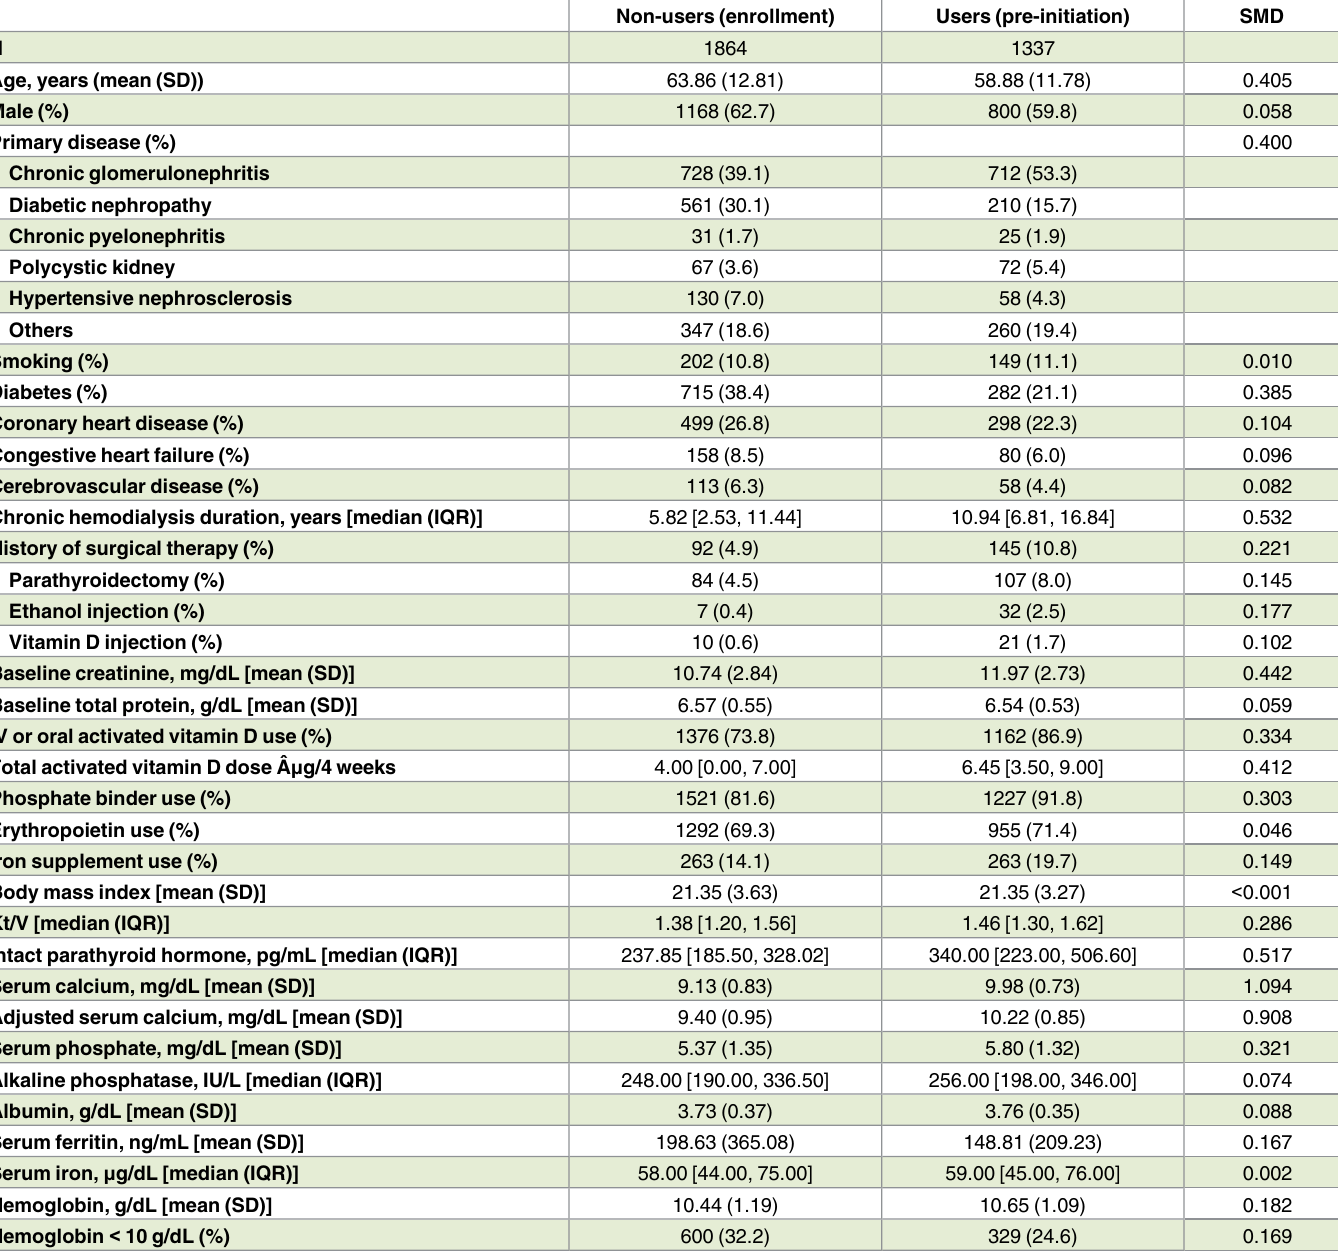
Table 1. Characteristics of the cinacalcet non-users at registry enrollment and of the cinacalcet initiators at the visit immediately prior to cinacal- cet initiation. Non-users (enrollment) Users